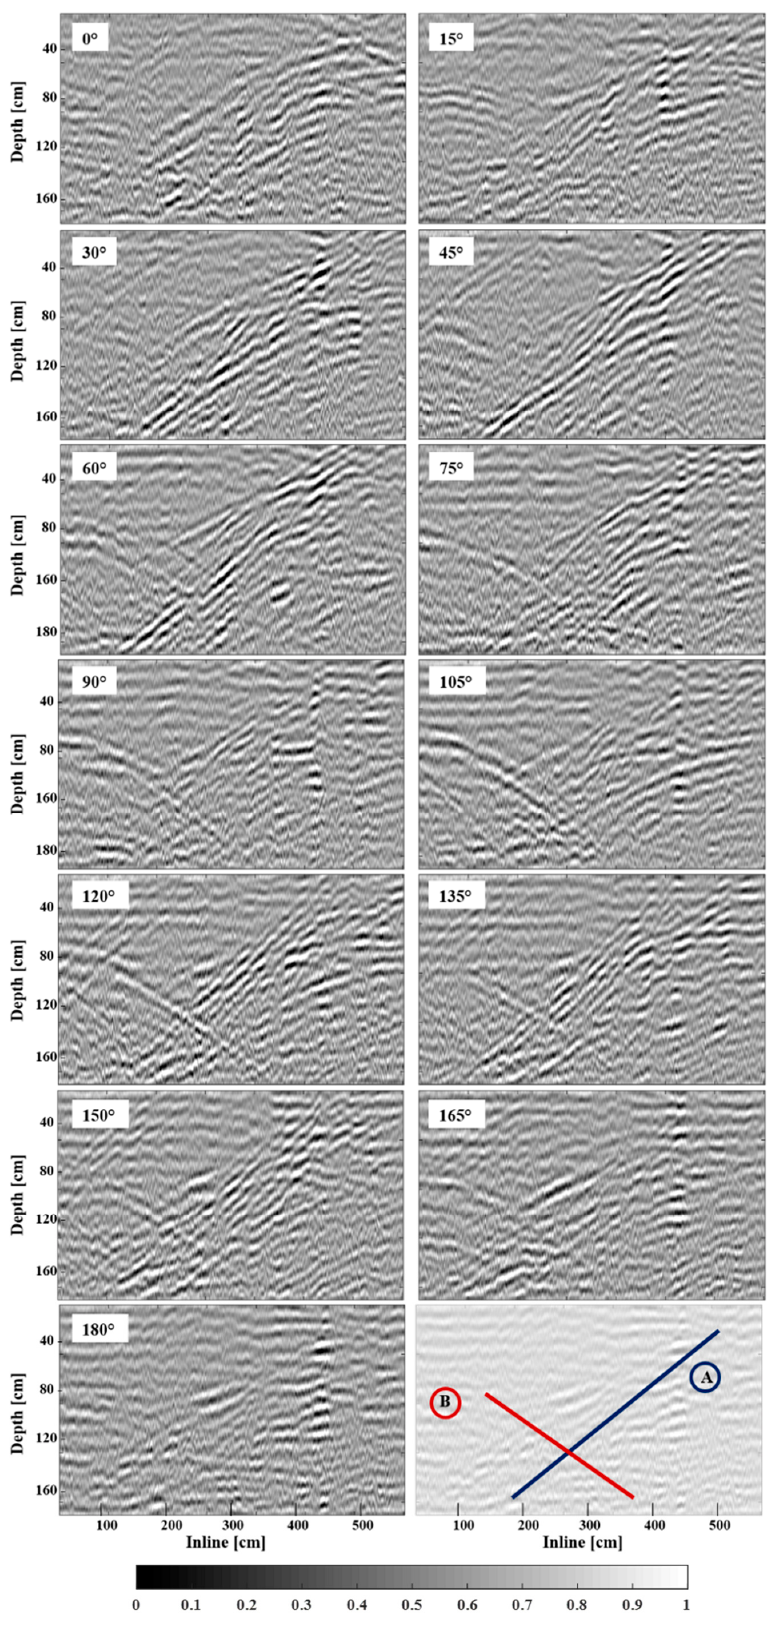
Figure 6. Results of the multi-azimuth survey. Angles are marked in each frame and a schematic sketch is provided to aid in the visual identification and recognition process.